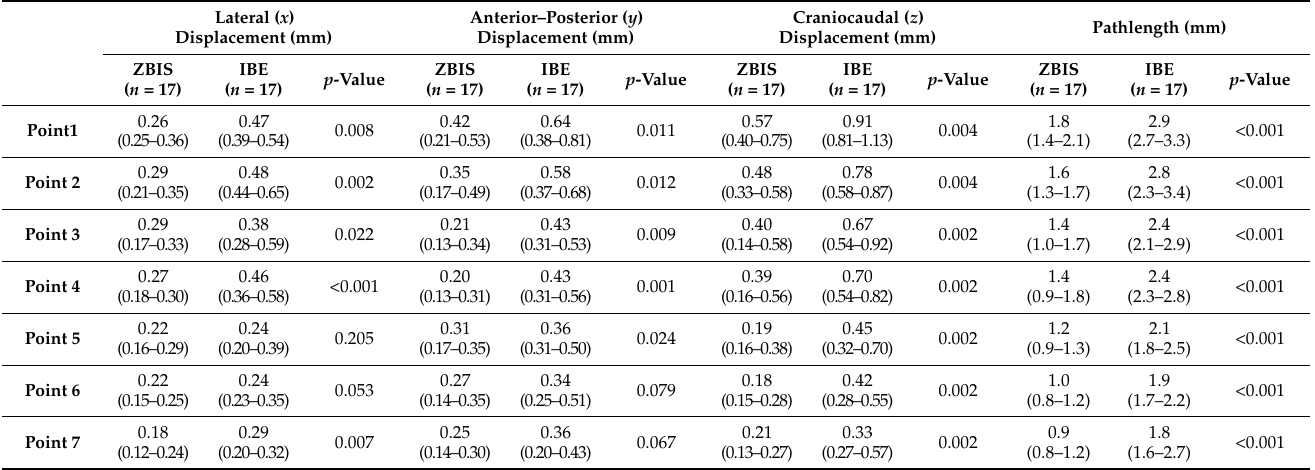
Table 2. Maximum displacement amplitudes, i.e., total displacement, in x -(lateral), y -(anterior– posterior) and z -(craniocaudal) direction and the pathlengths of the selected points 1–7 for both the Cook Medical Zenith bifurcated iliac side (ZBIS) and the Gore Excluder platform iliac branched endoprosthesis (IBE) groups. The following points were selected: the bifurcation of the main graft (Points 1 and 2), the IBD flow divider (Points 3 and 4), the distal markers of the IIA component (5 and 6) and the first bifurcation of the IIA.